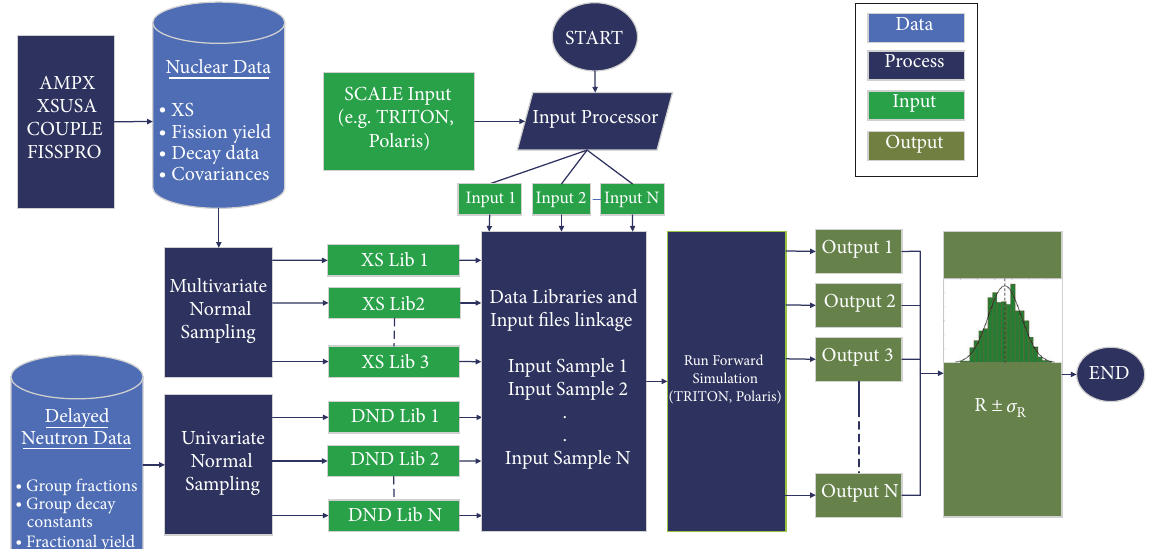
Figure 2: Uncertainty propagation of the nuclear and DND in the SCALE code